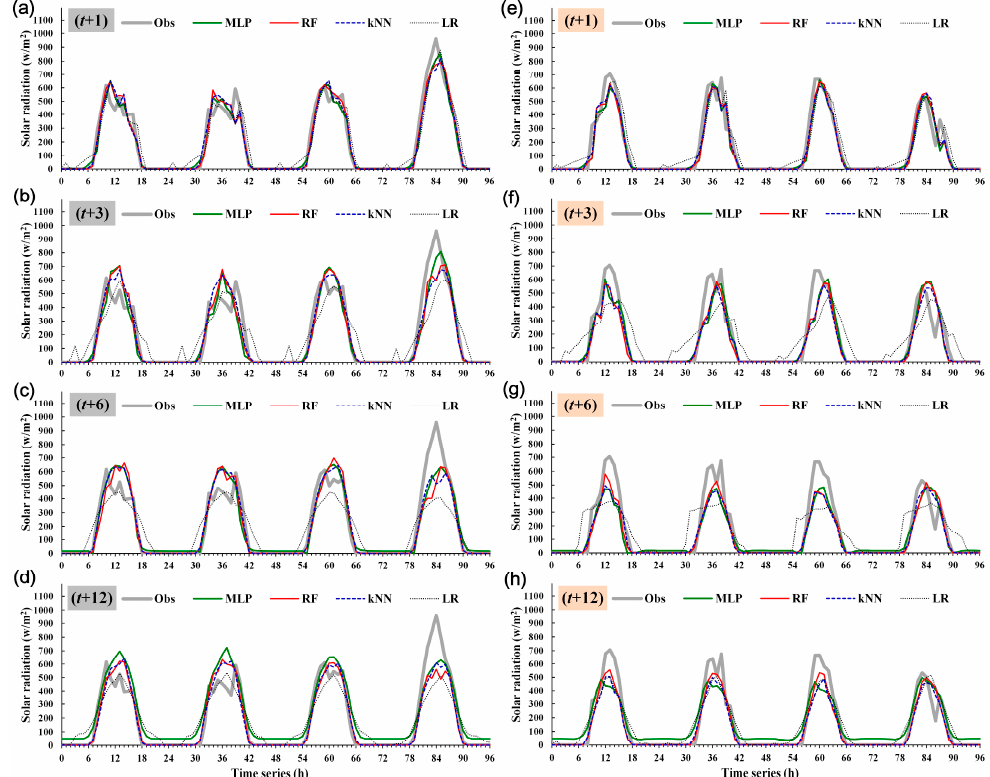
Figure 9. Observed and predicted changes in solar irradiance for the 4 consecutive days within 1 h ( t + 1), 3 h ( t + 3), 6 h ( t + 6), and 12 h ( t + 12) starting from: ( a – d ) the autumnal equinox on 22 September 2016, and ( e – h ) the winter solstice on 21 December 2016. Table 4. Performance of all models within t + 1 and t + 6 across all